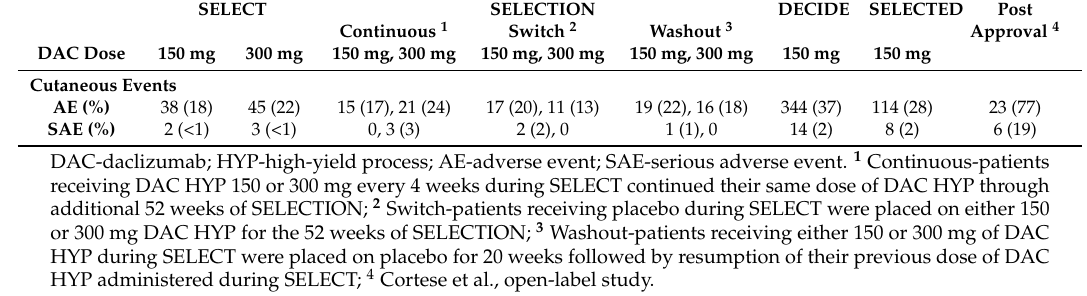
Clinical Trials